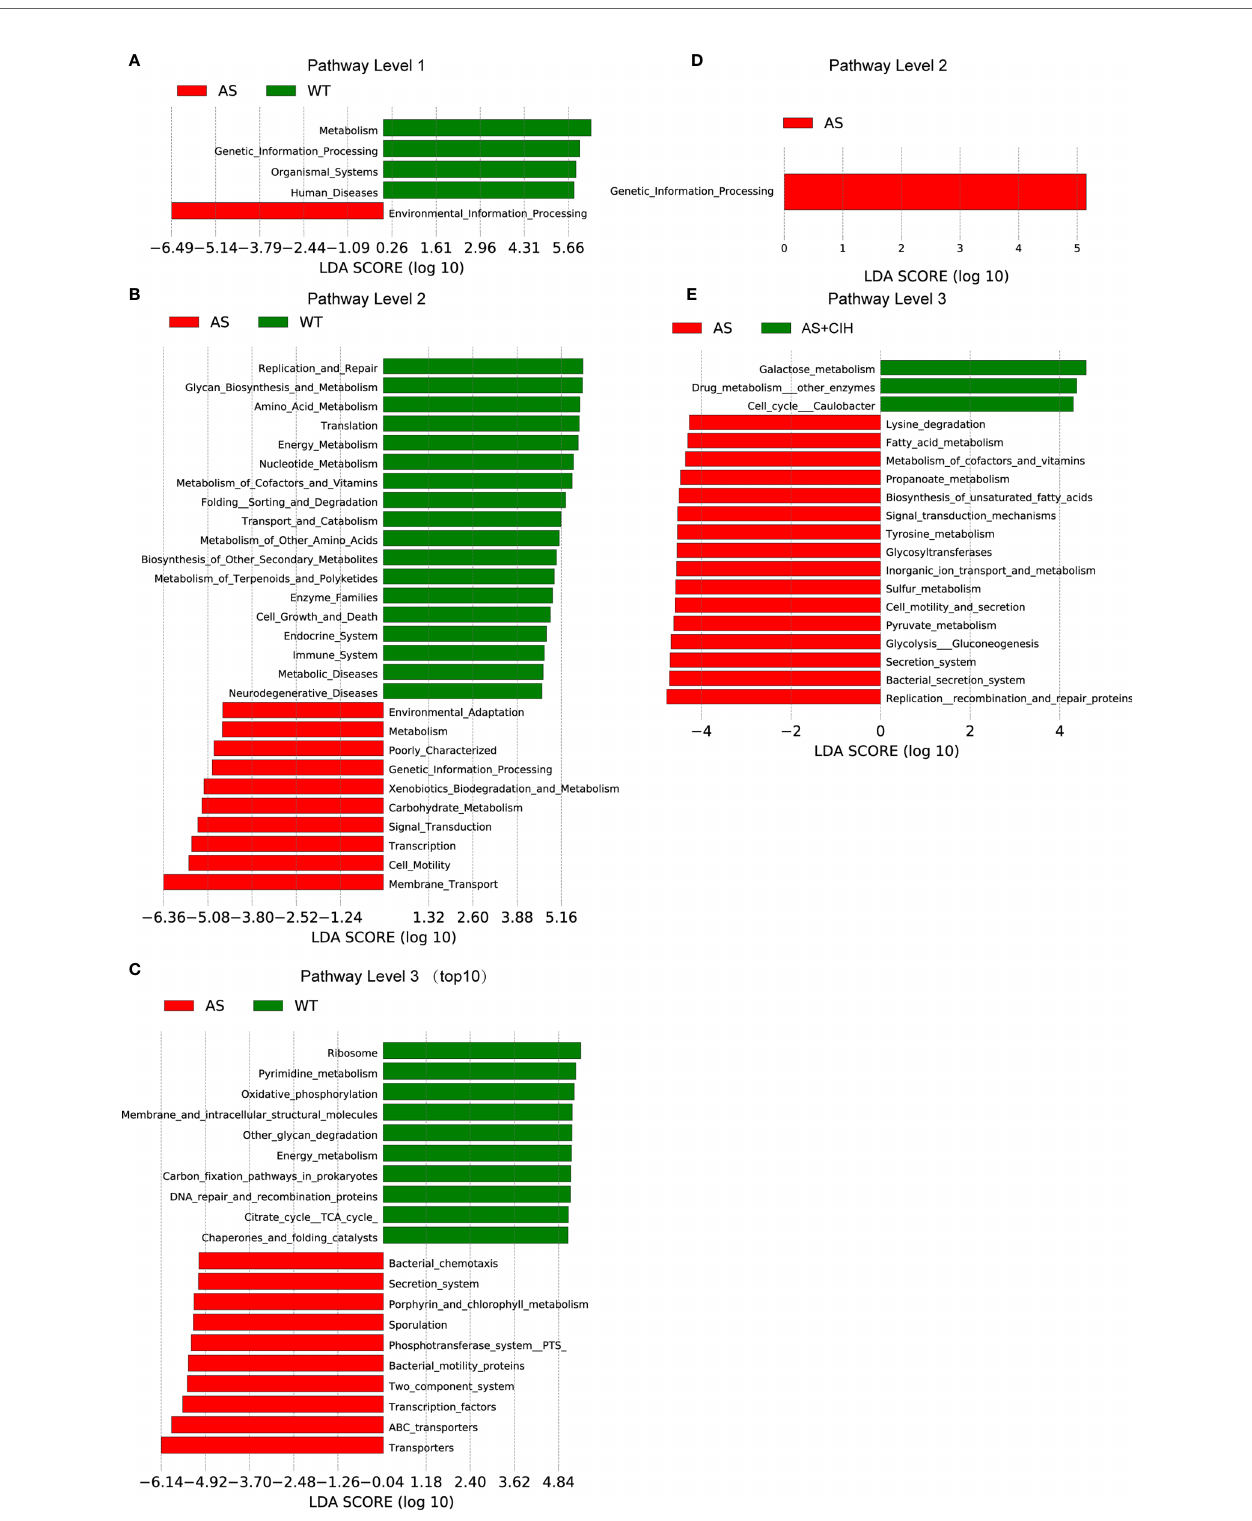
FIGURE 6 | Gut microbial functions in atherosclerotic mice changed following CIH. (A – C) PICRUSt shows that KEGG pathways were signi fi cantly different between AS (red) and control (green) mice with regard to the pathway level 1 (A) , 2 (B) and 3 (C) . (D, E) Bar plots of KEGG pathways signi fi cantly different between AS mice (red) and the mice housed under CIH conditions (green). n=7 for WT, and n=8 for AS and